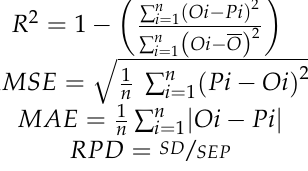
Figure 3. The statistical distributions of the R 2 ( a ), RMSE ( b ), MAE ( c ), and RPD ( d ) values of the ensemble DNN model using a bootstrap bagging approach for predicting the maximum carboxylation rate ( V cmax) and maximum electron transport rate ( J max) in the Naeba dataset. R 2 : coefficient of determination; RMSE: root mean square error; MAE: mean absolute error; RPD: ratio of performance to standard deviation. 3.2. Performance of DNN Models for Predicting Vcmax and Jmax from Reflectance in Different Leaf Types The DNN models used to predict V cmax and J max from reflectance in different leaf types were further explored, and the results are presented in Figure 4. In detail, the DNN model for predicting V cmax for sunlit leaves had a mean R 2 of 0.50, RMSE of 12.10 μ mol m − 2 s − 1 , MAE of 9.17 μ mol m − 2 s − 1 , and RPD of 1.42. In comparison, the DNN model for shaded leaves had a mean R 2 of 0.39, RMSE of 7.15 μ mol m − 2 s − 1 , and MAE of 5.64 μ mol m − 2 s − 1 . Furthermore, the mean RPD value of the DNN model for estimating the V cmax of shaded leaves only reached 1.26 (lower than 1.40), so its performance was classed as “C” (RPD < 1.40) only. Similar results were also found when predicting J max using the DNN model. The best predictive performance was achieved for sunlit leaves (mean R 2 = 0.49, RMSE = 21.68 μ mol m − 2 s − 1 , MAE = 16.76 μ mol m − 2 s − 1 , and RPD = 1.40). However, the DNN model had a relatively poor performance for predicating J max in shaded leaves (mean R 2 = 0.23, RMSE = 14.69 μ mol m − 2 s − 1 , MAE = 11.34 μ mol m − 2 s − 1 , and RPD = 1.13). In terms of R 2 and RPD values, it is worth noting that the predicted performances were higher in sunlit leaves than in shaded leaves for both V cmax and J max.